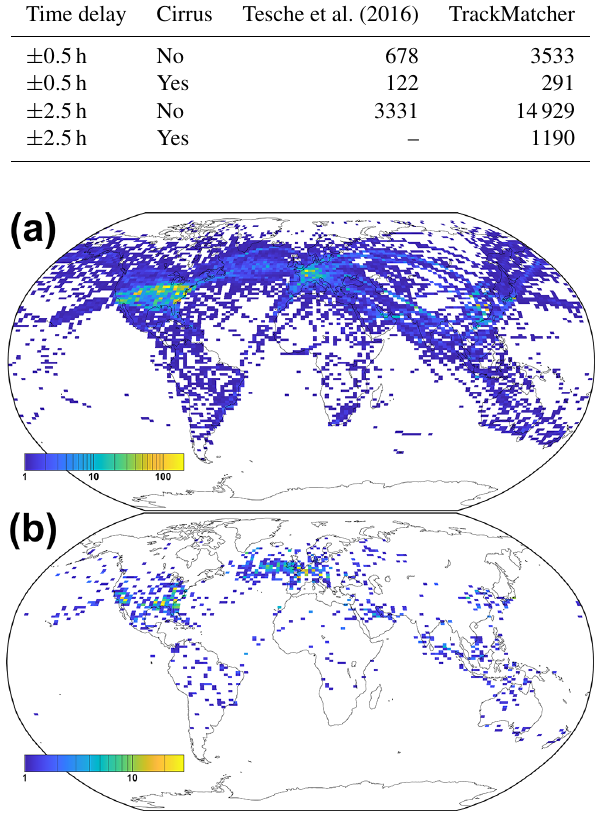
Figure 4. Gridded map (0.5 ◦ latitude by 1.0 ◦ longitude) of the num- ber of intercept points between the aircraft flight tracks above 5km height and the ground track of the CALIPSO satellite for Febru- ary 2012 for (a) all atmospheric conditions and (b) the situations in which cirrus is present at flight level. The maximum time difference between the primary and secondary tracks is constrained to